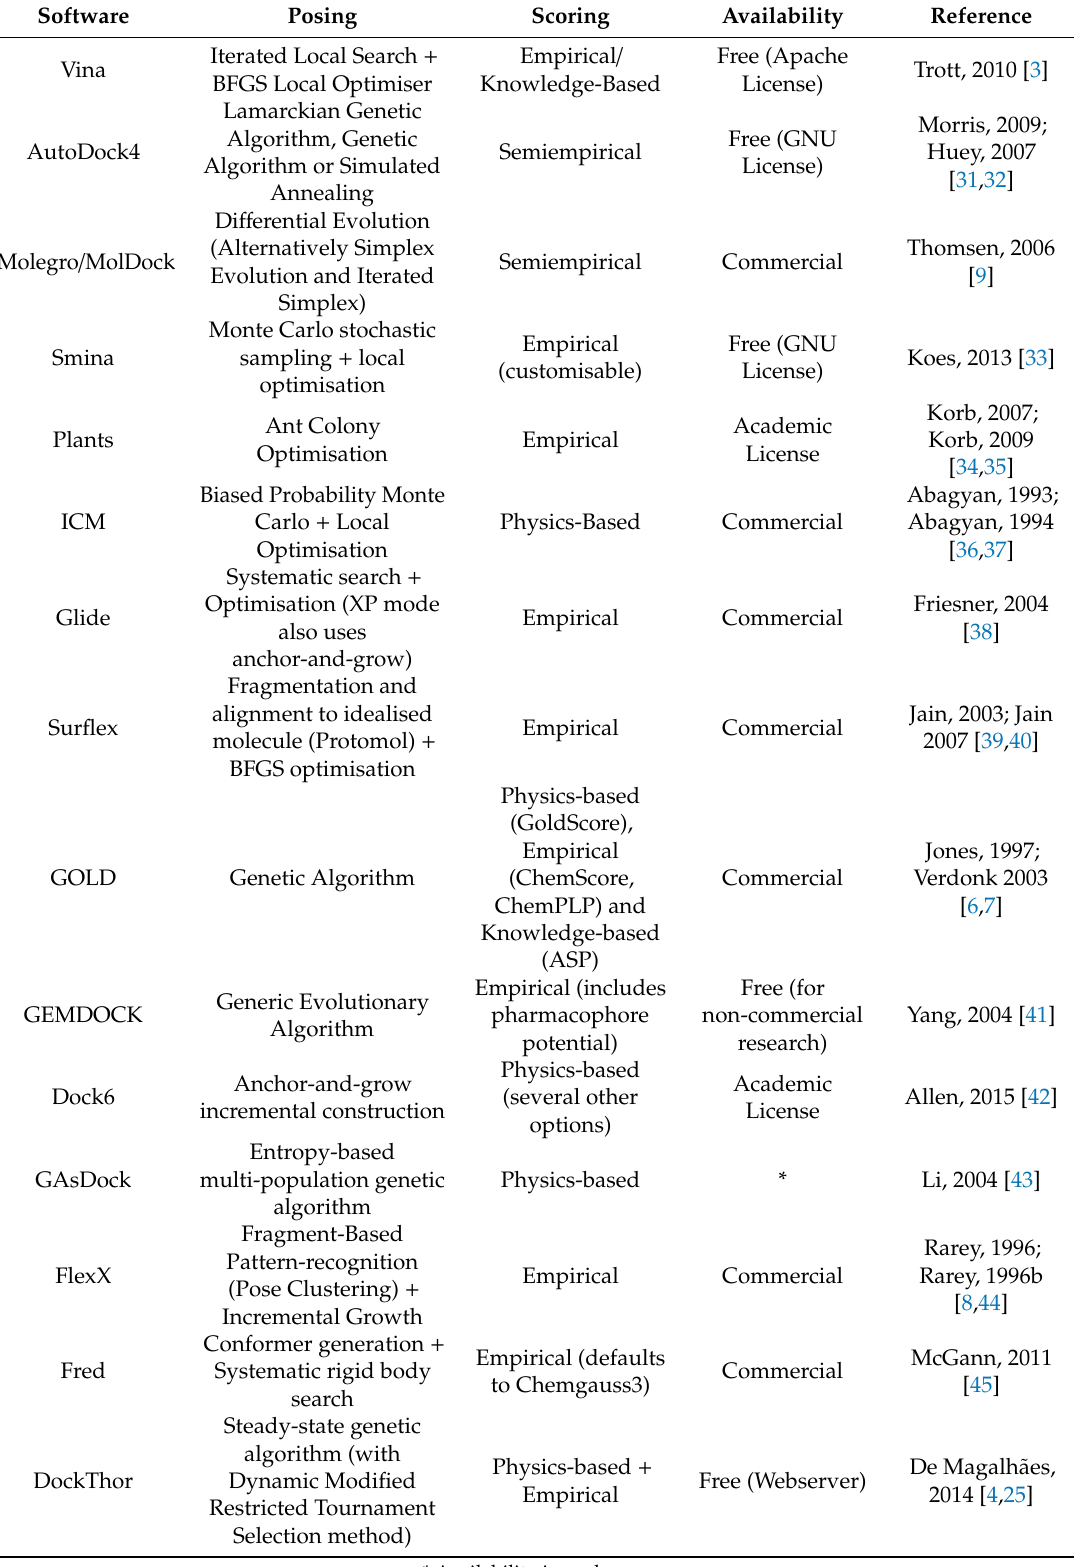
Table 1. Molecular docking